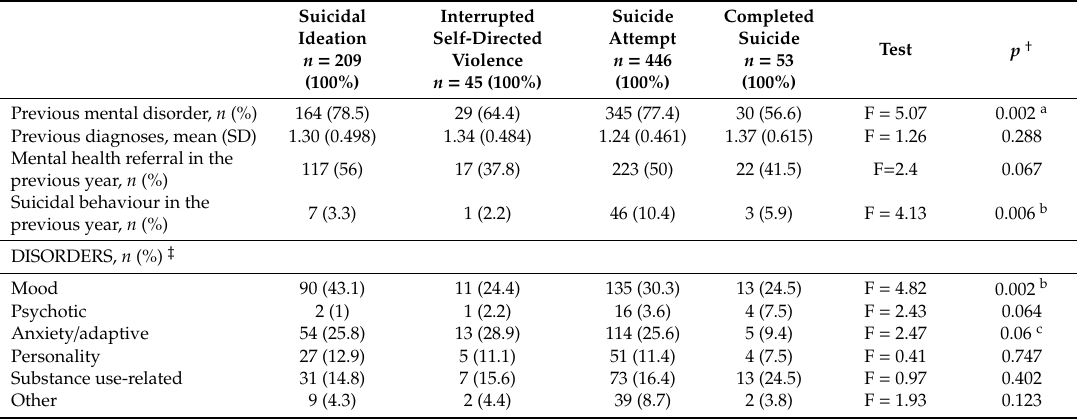
Table 3. Clinical characteristics according to type of suicidal